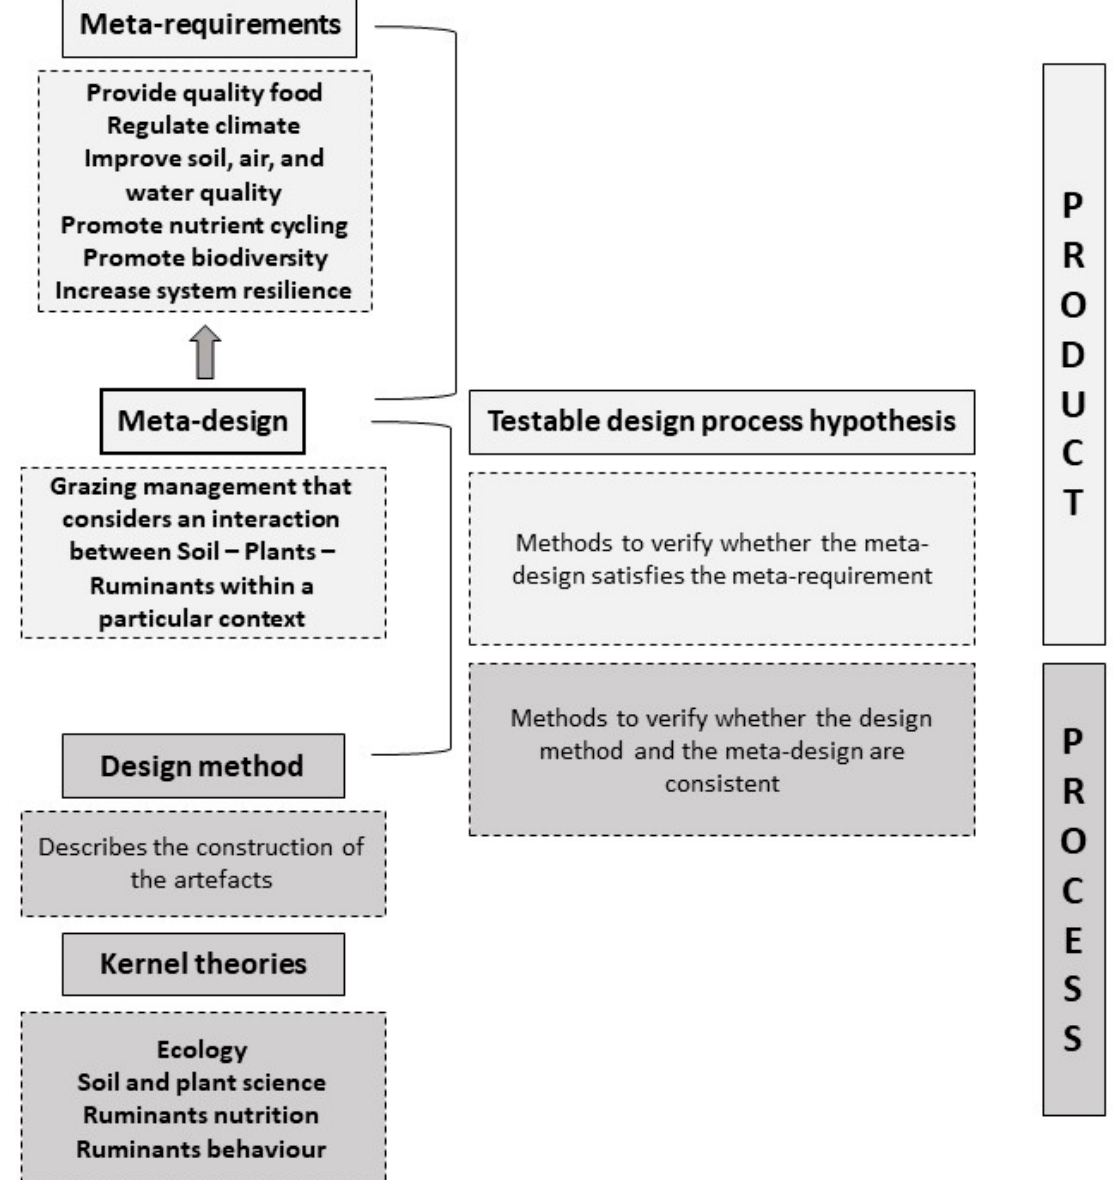
Figure 2. The framework of the design product and process with a description of the meta-requirements, meta-design, and kernel theories for designing healthier pastoral livestock production systems. Based on the design theory proposed by Walls et al. (1992 [28]).